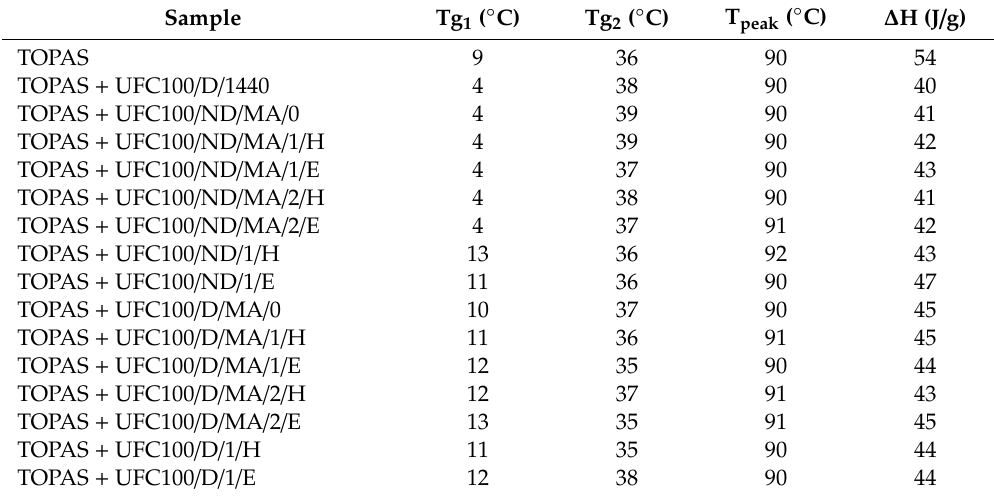
Table 5. Tabularized maximum values of ethylene segments glass transition temperatures (Tg 1 ), norbornene segments glass transition temperatures (Tg 2 ), peak temperature (T peak ) of the softening